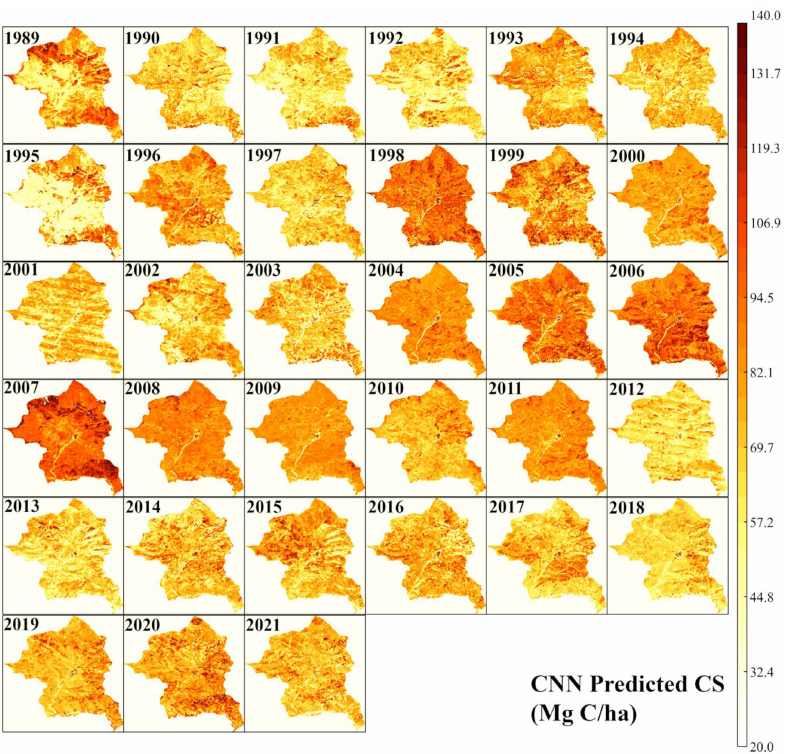
Figure 6. Distribution of the CNN model’s pixel-by-pixel carbon stock (Mg C/ha) projection results for 1989–2021, and the carbon stock distribution range is 20–140 Mg